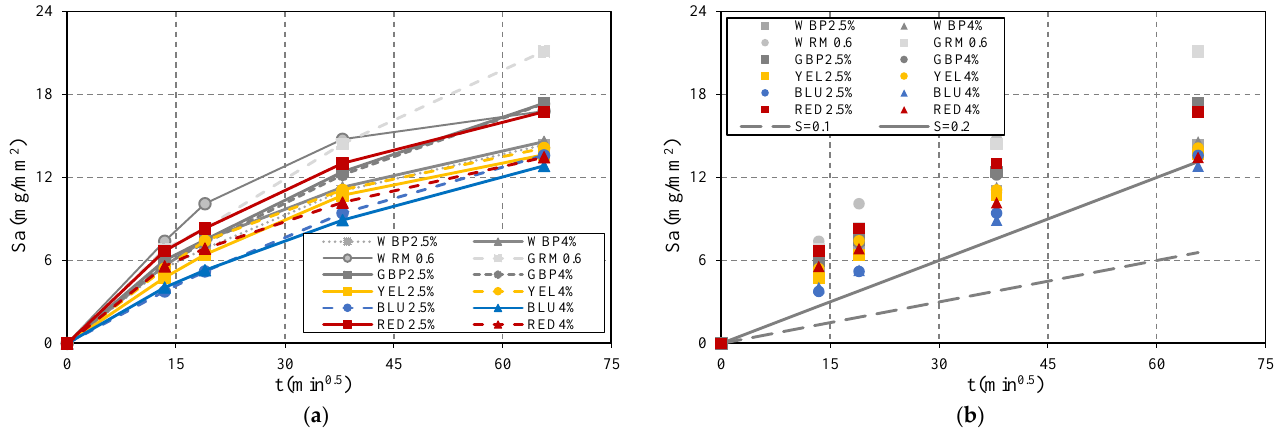
Figure 1. Capillary absorption coefficient Sa for the restoration mortar based on reference WRM0.6 and GRM0.6: ( a ) Capillary water absorption vs. square root of time; ( b ) fit of Sa values on the limits of quality for concrete.